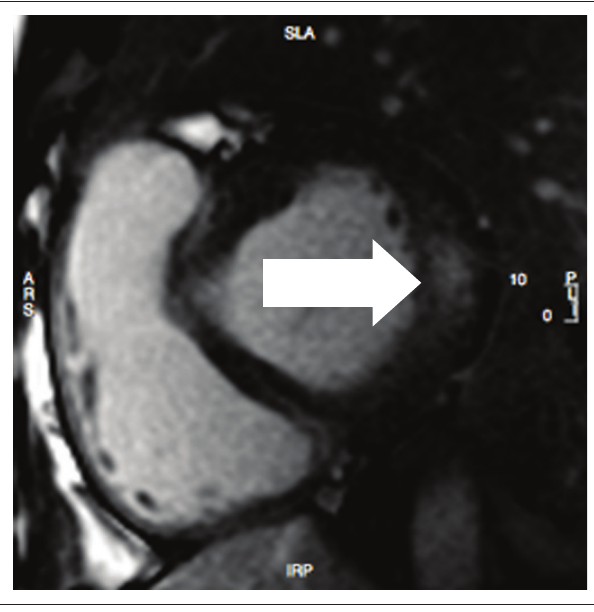
FIGURE 10: Basal lateral mid-wall LGE in Fabry disease. The differential for this scar pattern includes previous myocarditis, which T1 mapping would